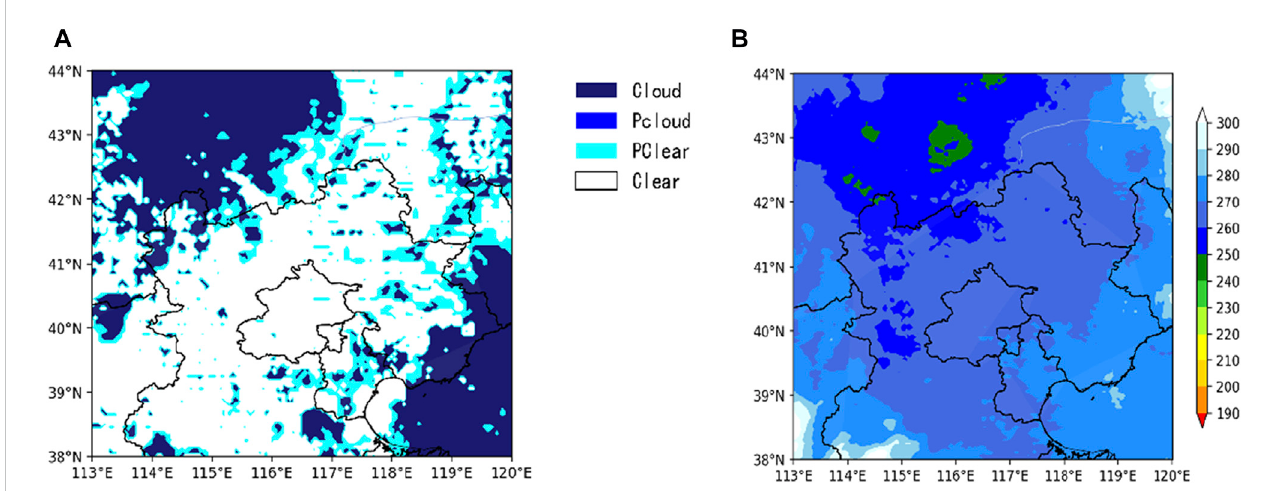
FIGURE 2 Distributions of AGRI (A) cloud detection (cloud, pcloud, pclear, and clear represent cloudy, probably cloudy, probably clear, and clear observations, respectively), (B) channel 9 brightness temperature before QC (units: K) at 00 UTC on 9 August 2019.